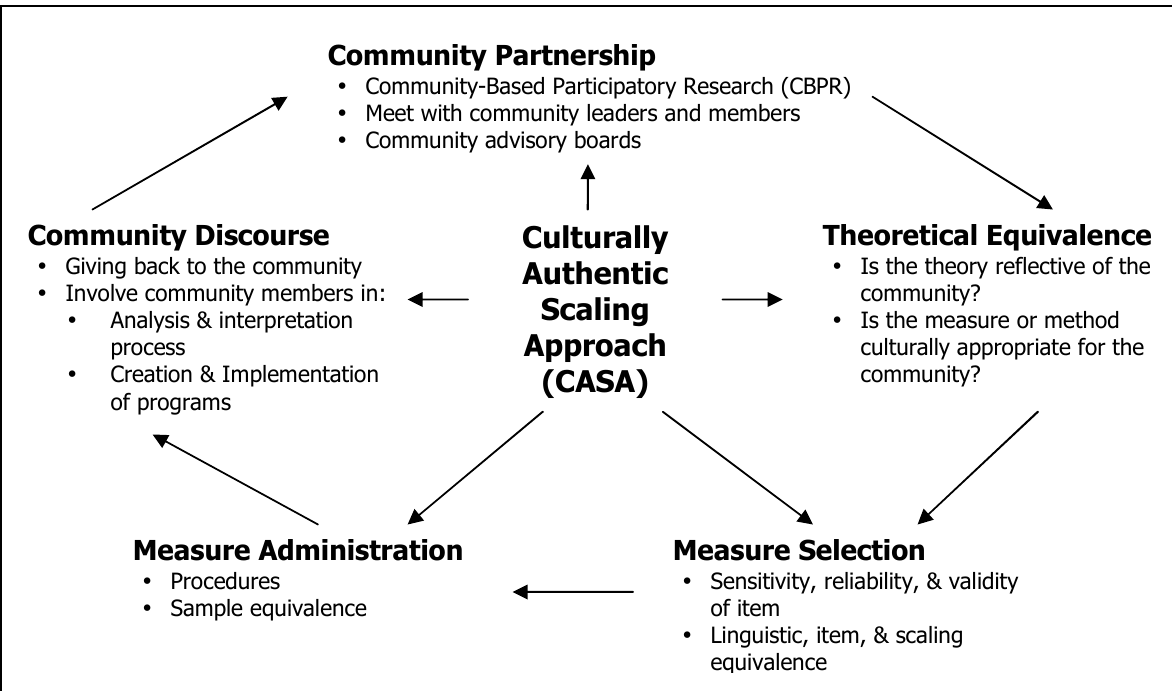
Model of the Culturally Authentic Scaling Approach